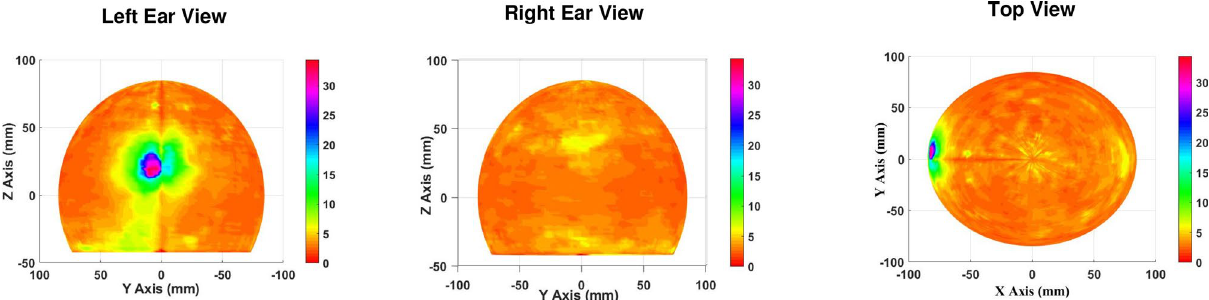
2 Figure 7. H MUSIC cost function plot of a subject P1 having seizure on left temporal